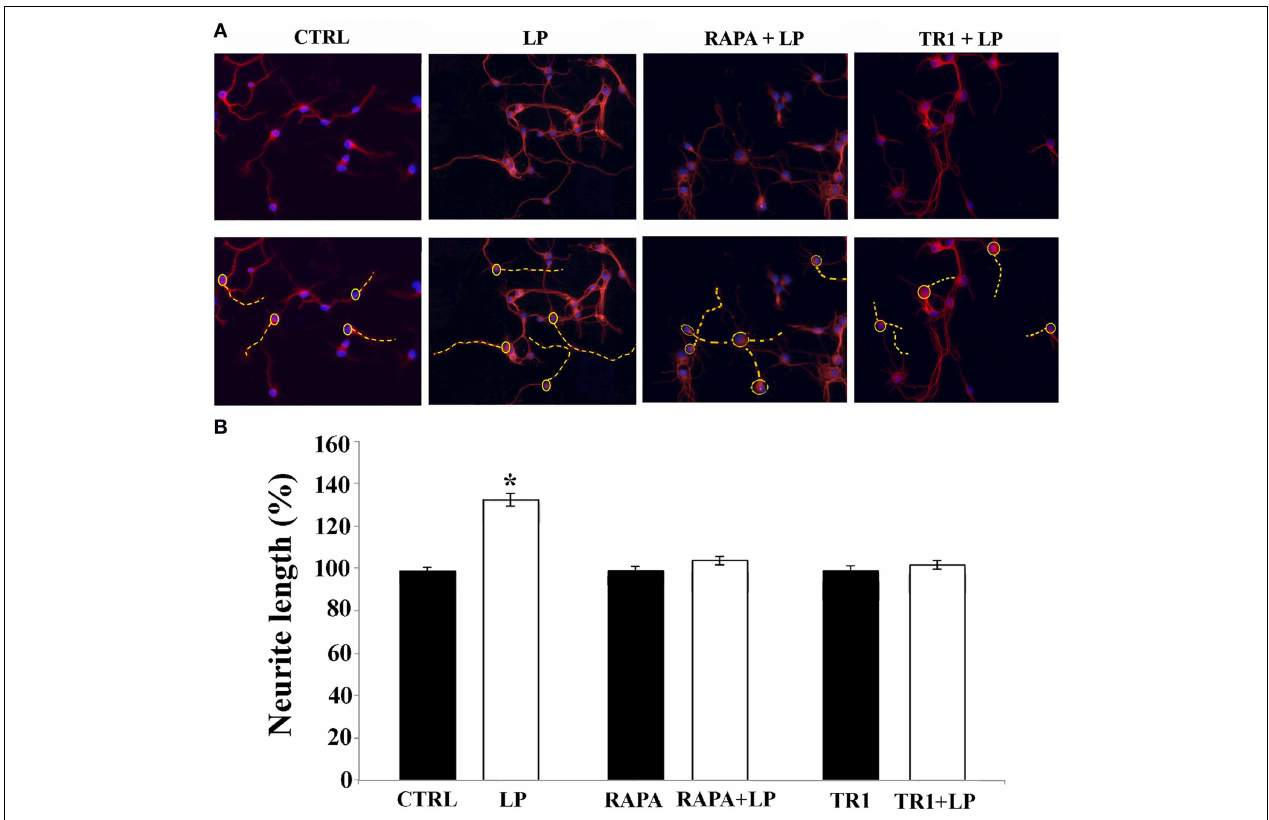
FIGURE 2 | mTOR signaling pathway is required for neurite elongation induced by 5-HT7R stimulation. Cortical neurons were treated for 2h with the 5-HT7R selective agonist LP-211 (LP, 100nM), or the mTOR inhibitors rapamycin (RAPA, 20nM), or torin 1 (TR1, 250nM) with or without LP. (A) Representative Tuj1 immunostaining of neuronal cultures (magnification 20x). The images in the lower row are the same of the upper row with the addition of the dashed yellow lines manually